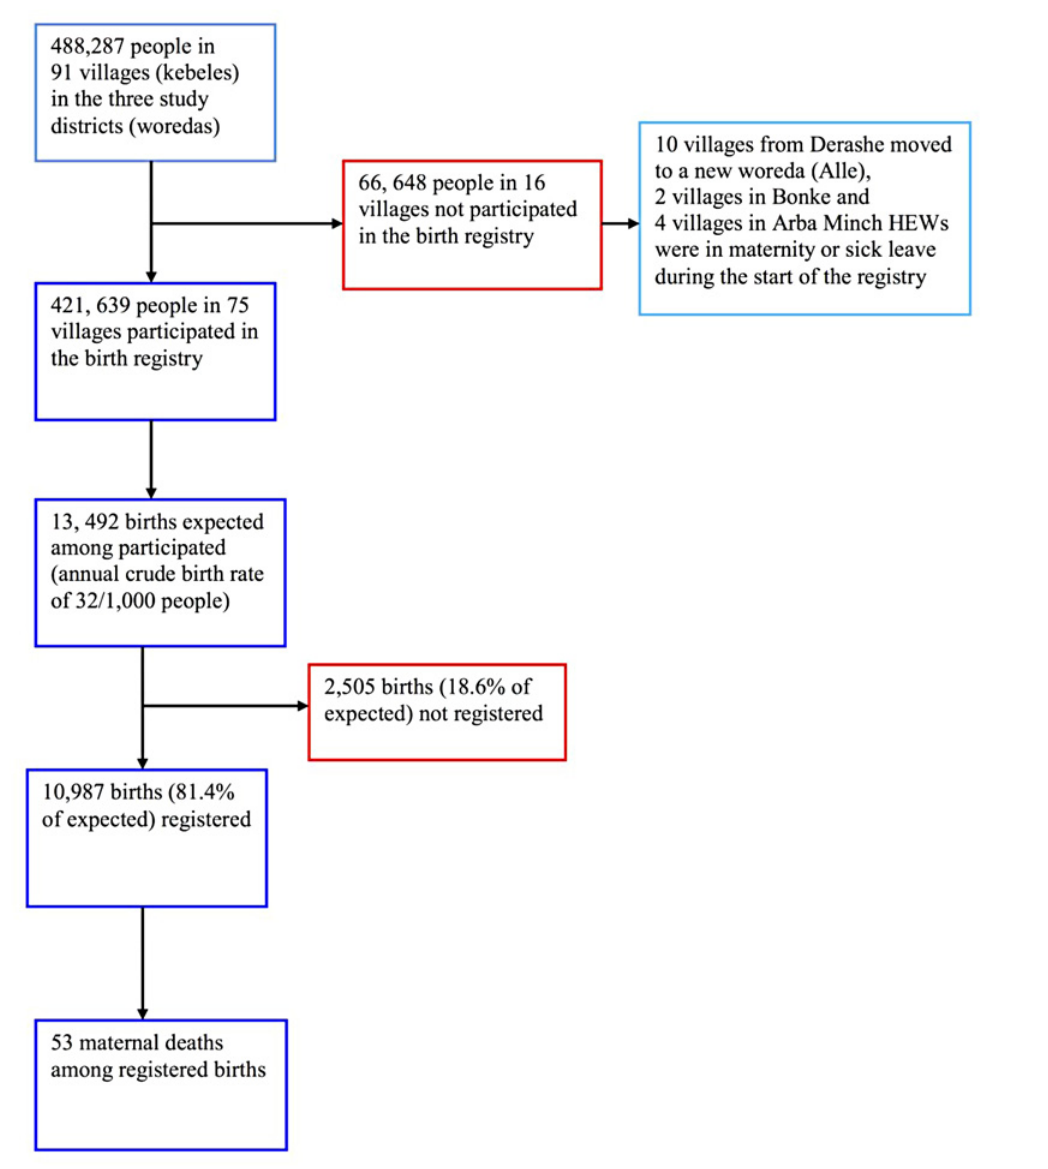
Fig 2. The profile of the birth